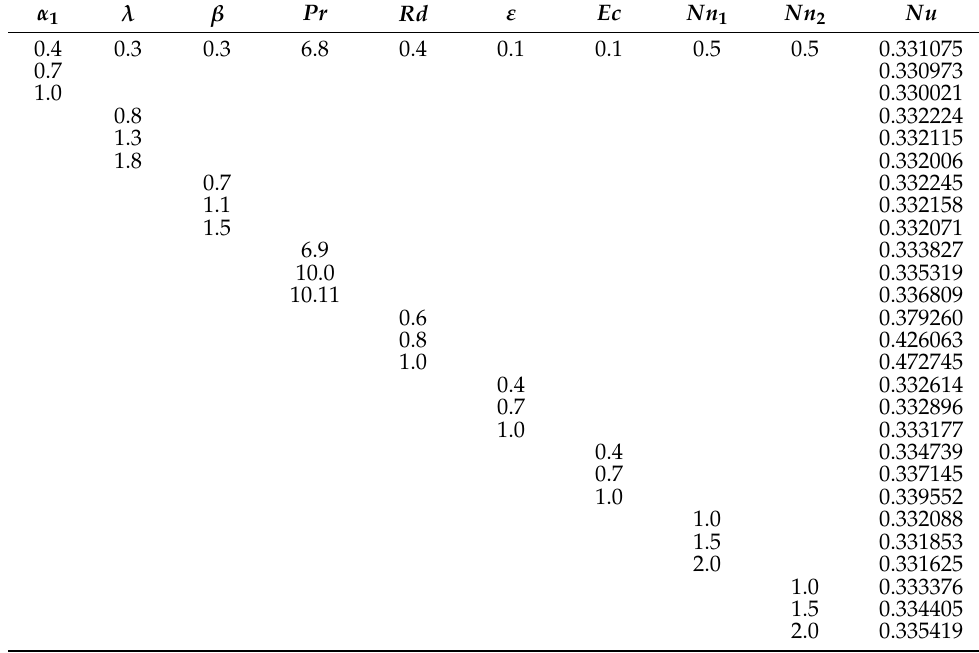
Table 3. Numerical values of Nusselt number with varying values of the